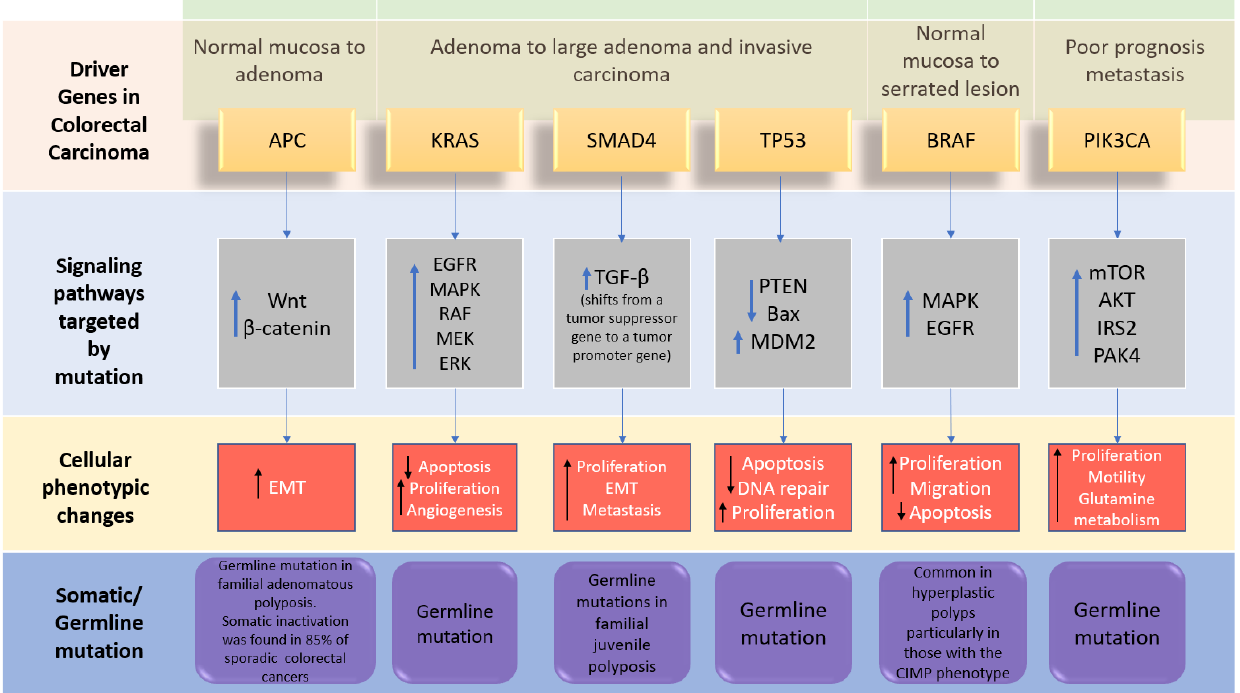
Figure 2. The driver genes and signaling pathways involved across the CRC adenoma – carcinoma sequence from the transition of normal epithelium through to the metastasis stage in colorectal cancer (adopted from [6]). IRS2; insulin receptor substrate 2, MDM2; Mouse double minute 2 homolog, mTOR; Mammalian target of rapamycin. PAK4; p21 (RAC1) activated kinase 4, EMT; epithelial – mesenchymal transition.